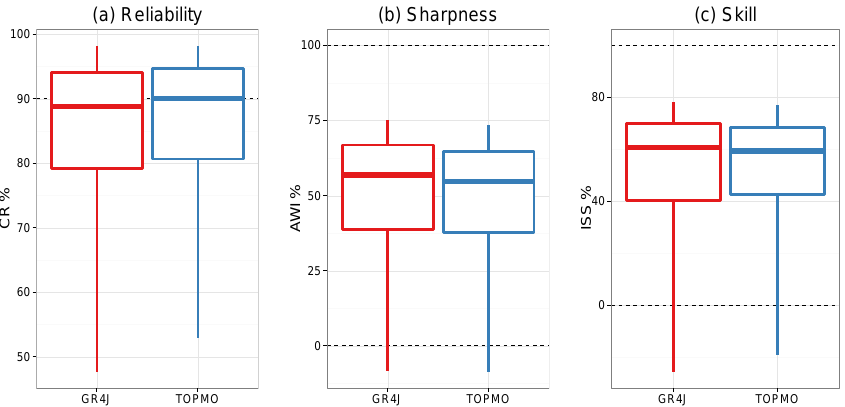
Figure 4. Distributions of the three performance criteria. Boxplots (5th, 25th, 50th, 75th and 95th percentiles) summarise the variety of scores over the 907 catchments of the data